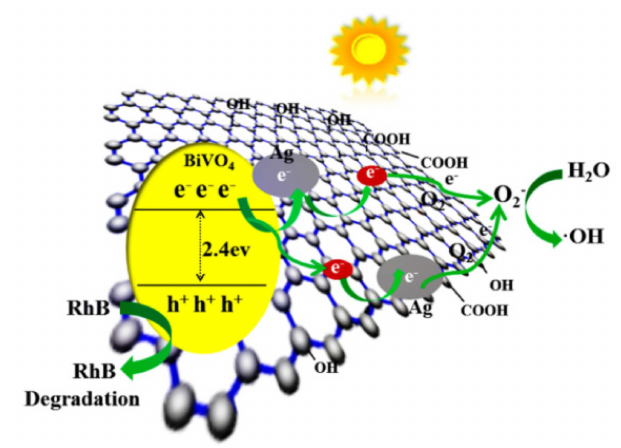
Figure 8. Photocatalytic reaction mechanism for AgGB